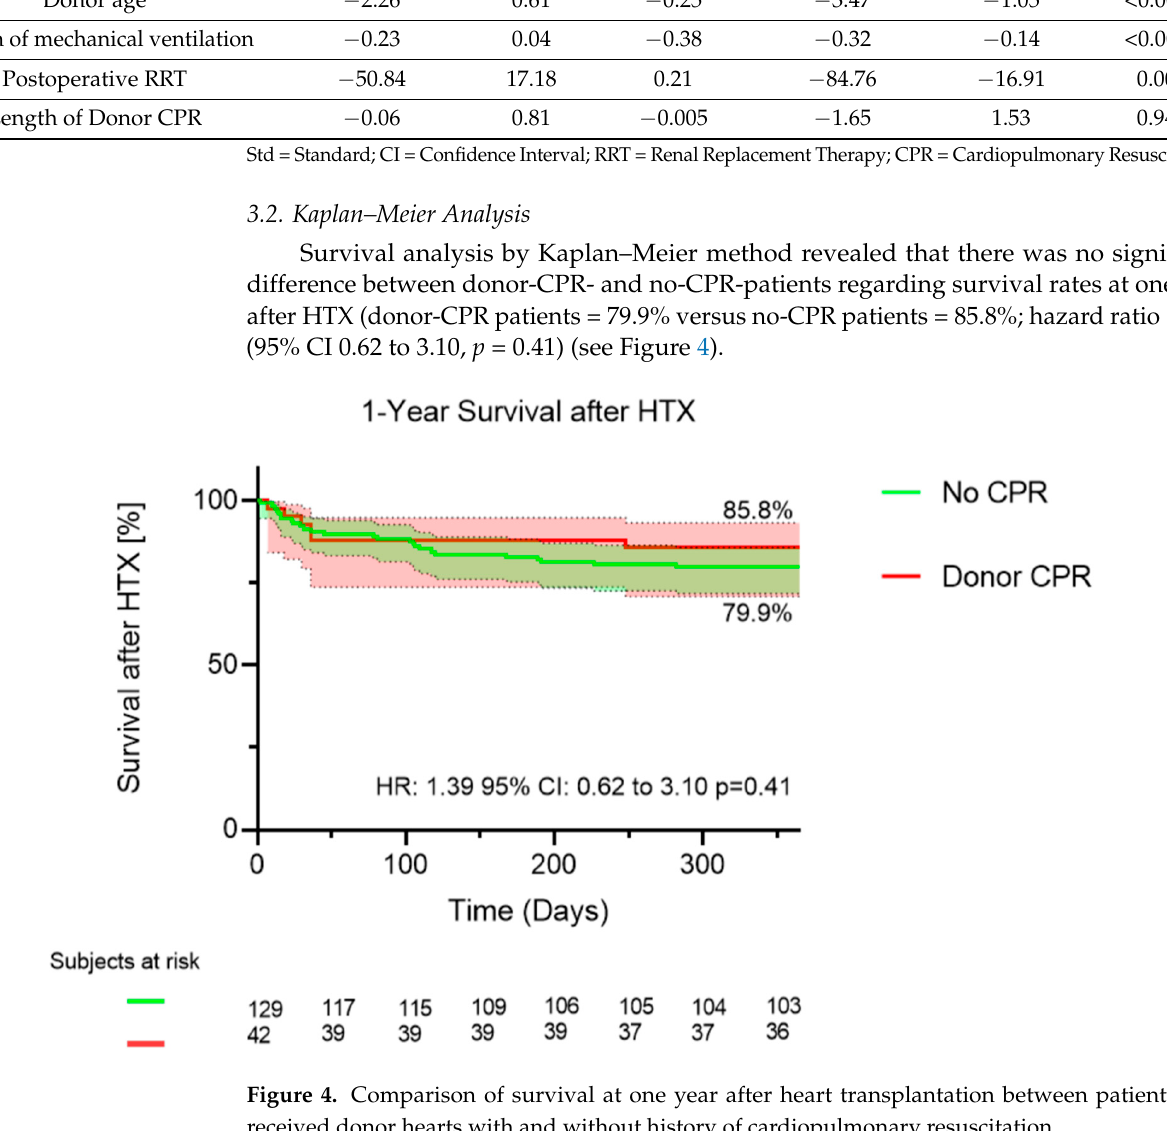
Std = Standard; CI = Confidence Interval; RRT = Renal Replacement Therapy; CPR = Cardiopulmo-